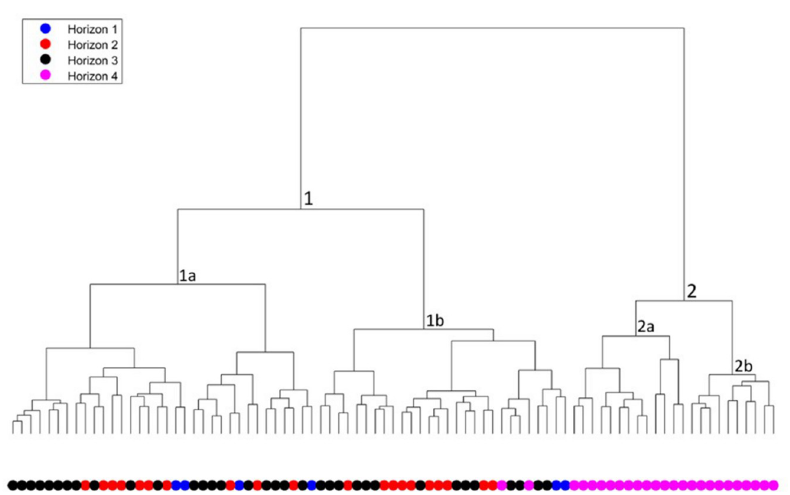
Fig 10. Cluster tree for the 85 Iron Age II OSJ and Rosetta jars with the chronological horizons. The lines at the base represent one item in the assemblage, and each branch represents a segregated morphological group (type variation) based on similarity. The color-coded circles beneath the branches represent the group/type’s chronological horizons to which they belong.